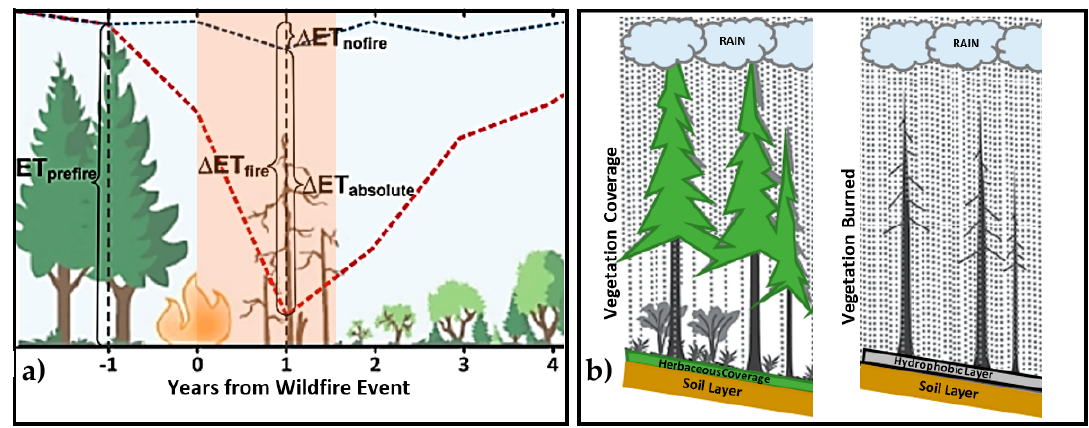
Figure 1. Conceptualization of the wildfire effects over a terrain slope affecting the vegetation coverage in pre-fire and post-fire conditions: ( a ) the effects on evapotranspiration decreasing, modified after [28] and ( b ) the effects on infiltration capacity of the terrain during rainfalls, modified after [18].